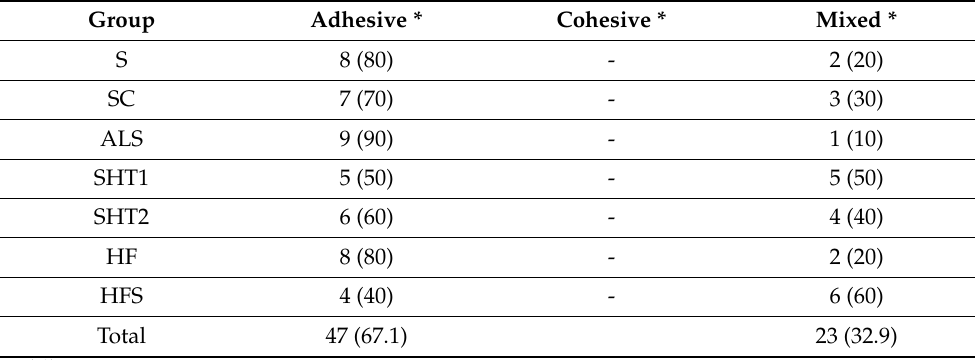
Table 4. Types of bond